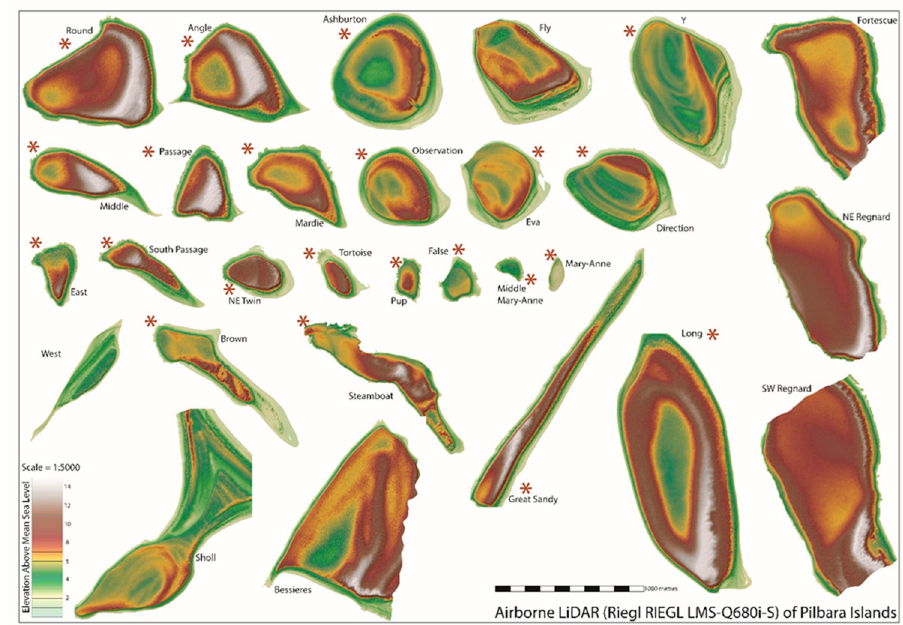
Figure 2. Schematic representing the Pilbara reef islands surveyed using terrestrial airborne LiDAR during October of 2016. The N = 22 islands marked by a red asterisk (*) had complete sub-aerial LiDAR data and were used in the analyses. The remaining islands had incomplete LiDAR data, and therefore were excluded from the analyses.